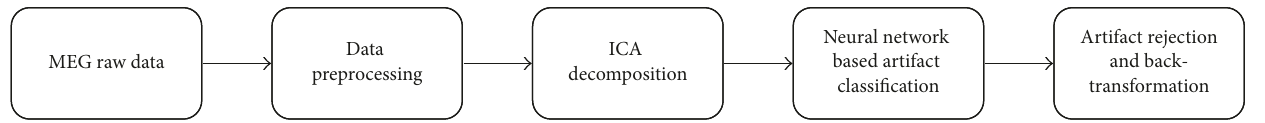
Figure 1: Workflow of the DCNN-based model for cardiac and ocular artifact removal in MEG